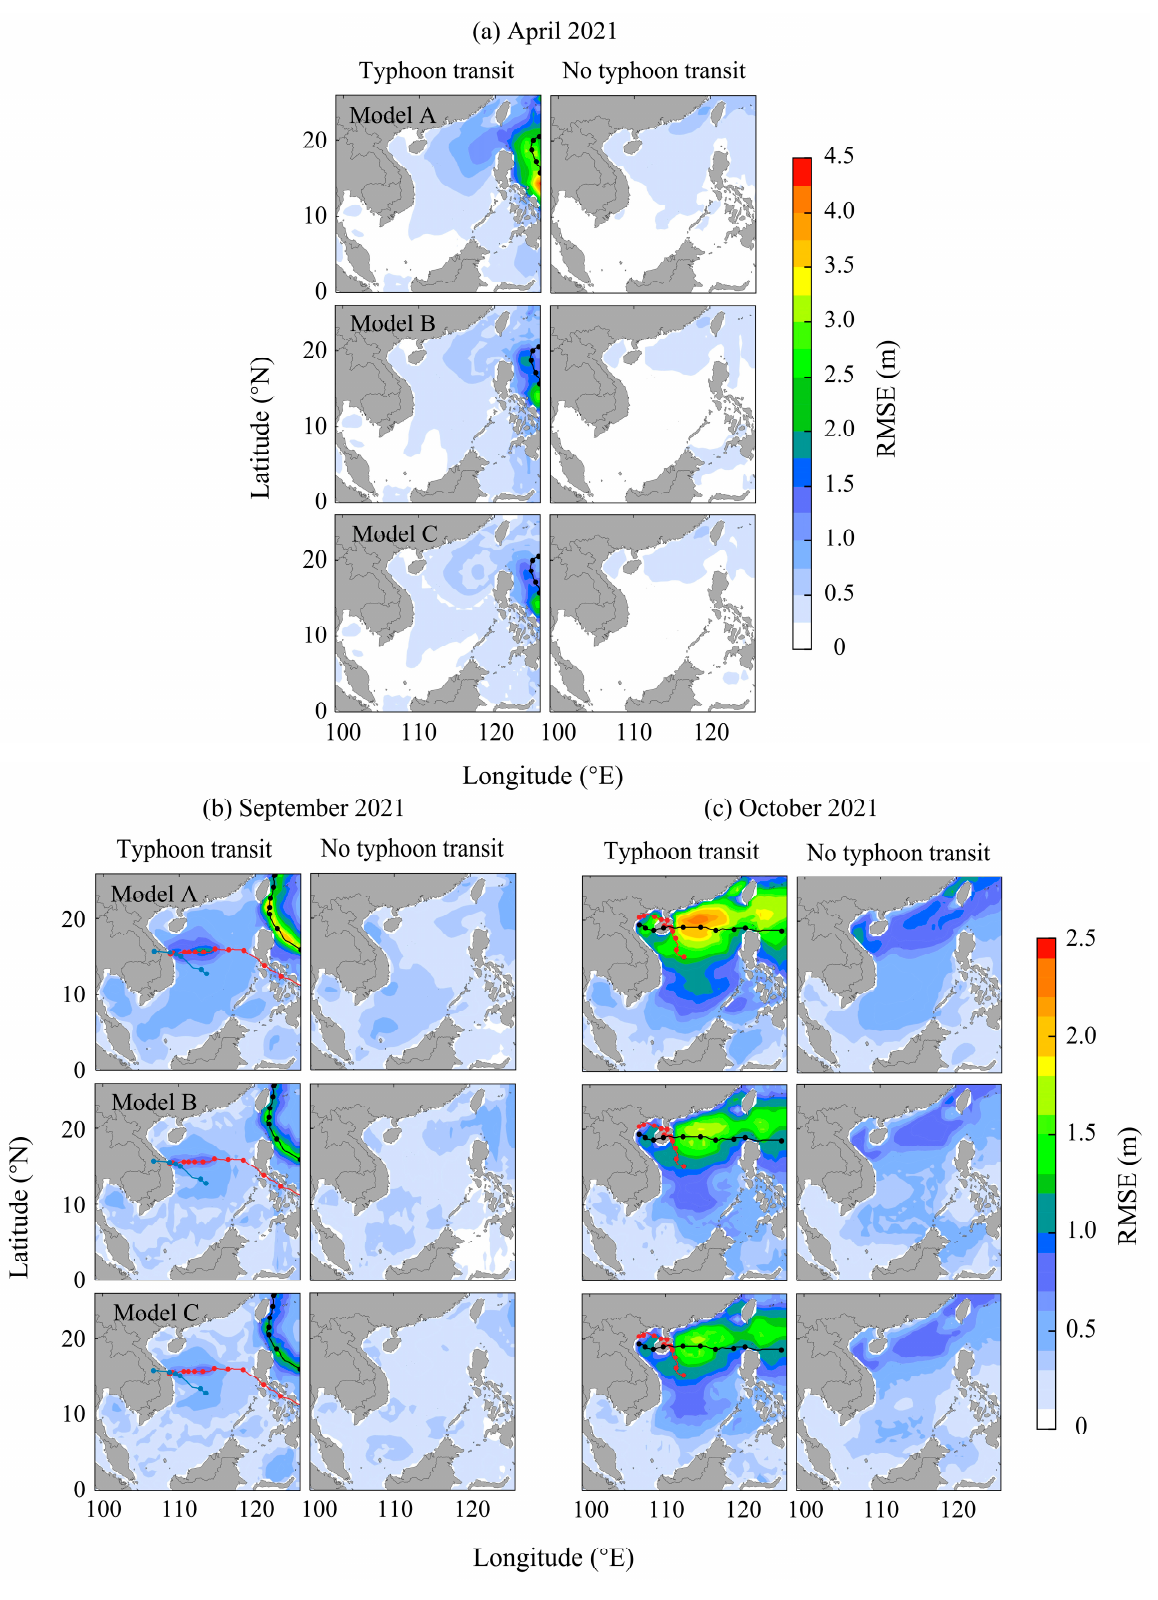
Figure 8. Spatial distribution of RMSE in the 24-h SWH forecasting for months of extreme weather occurrence. ( a – c ) April, September, and October 2021,